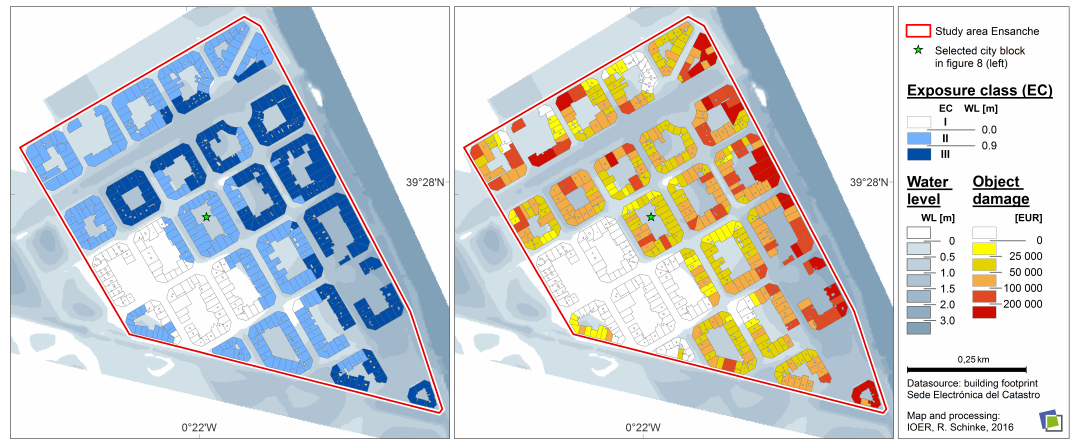
Figure 7. Characterisation of exposure classes based on the design flood ( left ) and the calculation results of the reference situation with object-related damage to residential buildings ( right